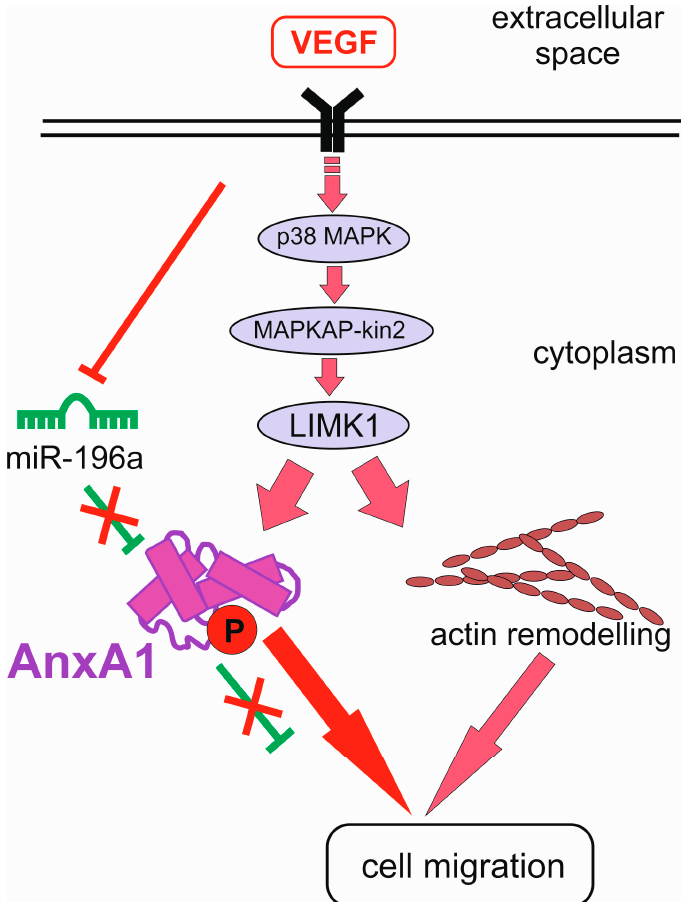
Figure 1. Vascular endothelial growth factor (VEGF) downregulates miR-196a to increase annexin A1. The negative feedback loop of miR-196a to annexin A1 (green T-bar) is attenuated by VEGF signalling (pink arrows), which induces a blockade of miR-196a expression (red T-bar), leading to an increase of annexin A1 and promoting endothelial cell migration.